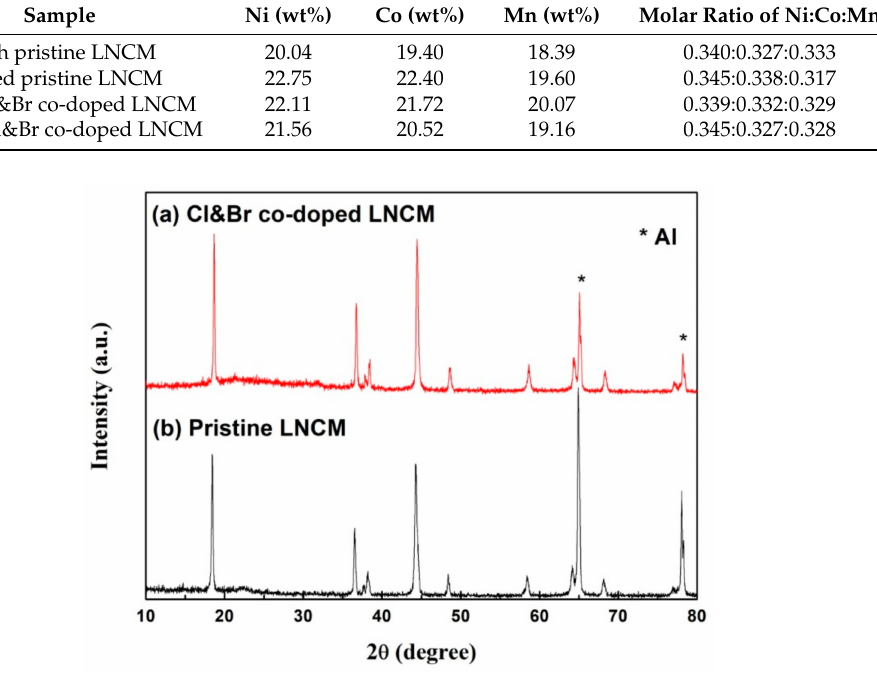
Figure 7. XRD patterns of the synthesized LiNi 1/3 Co 1/3 Mn 1/3 O 2 electrodes after 100 cycles: ( a ) Cl&Br co-doped LNCM; ( b ) Pristine